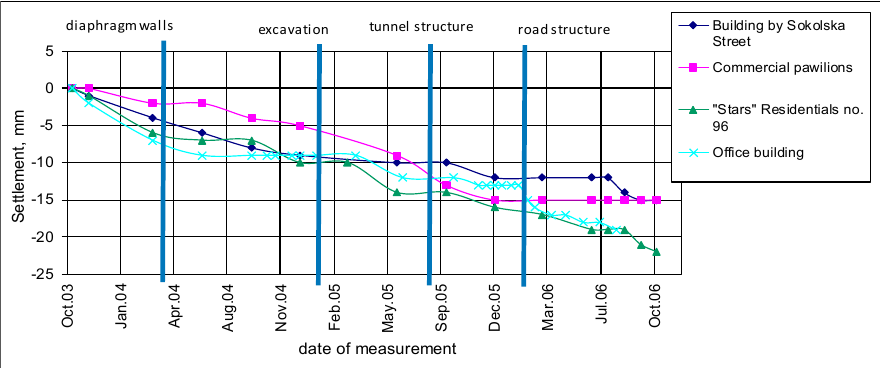
Figure 12. Settlement of selected objects measured on benchmarks (construction of the tunnel under the roundabout in Katowice—objects with significant settlements).